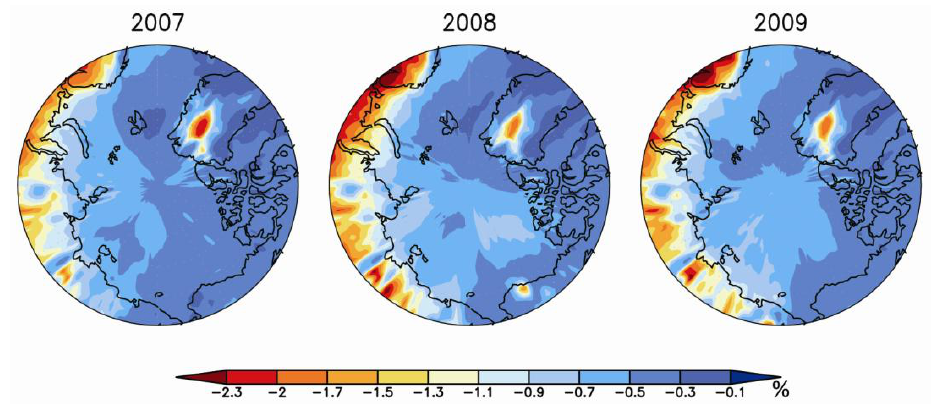
Fig. 4. Modeled change in snow and ice albedo due to sBC in and around the Arctic Ocean (north to 66°N) in spring 2007–2009. Fig.4. Modeled change in snow and ice albedo due to sBC in and around the Arctic Ocean (north to 66°N) in spring 2007-2009. Arctic, which was much larger than those in other Arctic re- gions ranging 0.39 % to 0.64 %. The averaged value over the Arctic north of 66° N is 0.4–0.6 % from spring 2007–2009, lower than the estimates of Park et al. (2005), but Fig.4. Modeled change in snow and ice albedo due to sBC in and around the Arctic Ocean (north to 66°N) in spring 2007-2009.